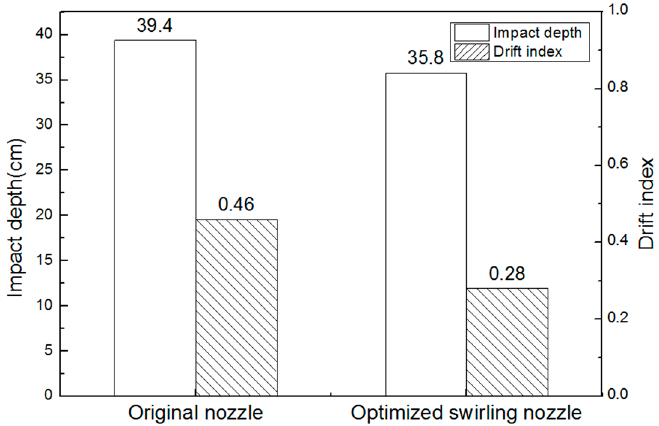
Figure 20. Impact depth and drift index of molten steel for SEN before and after optimization.